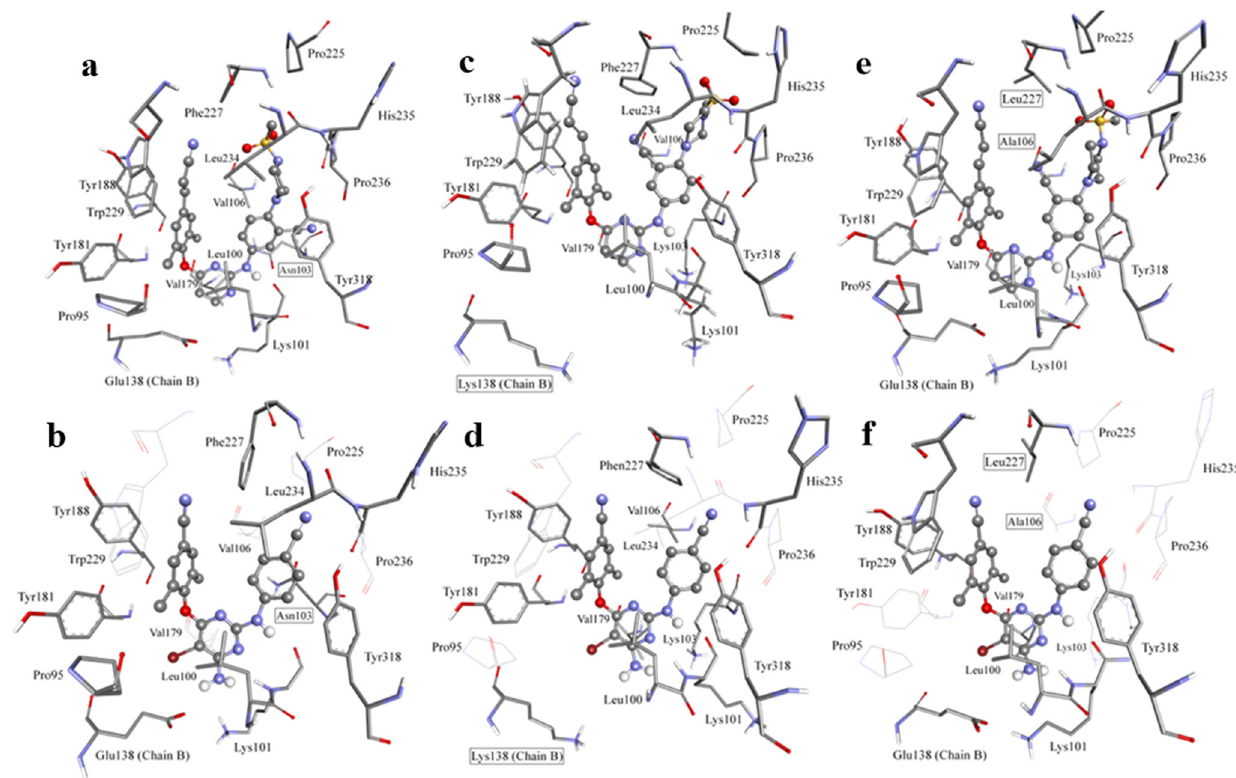
Fig. 7 Interactions in the representative structures (most abundant cluster) of NNRTIs and HIV-1 RT. a K103N- 18b1 , b K103N-ETR, c E138K- 18b1 , d E138-ETR, e V106A/F227L- 18b1 and f V106A/F227L-ETR. Mutated amino acids are presented inside a box. Amino acids that are not involved in interactions with ETR are represented in lines. Inhibitor is represented as balls and sticks.